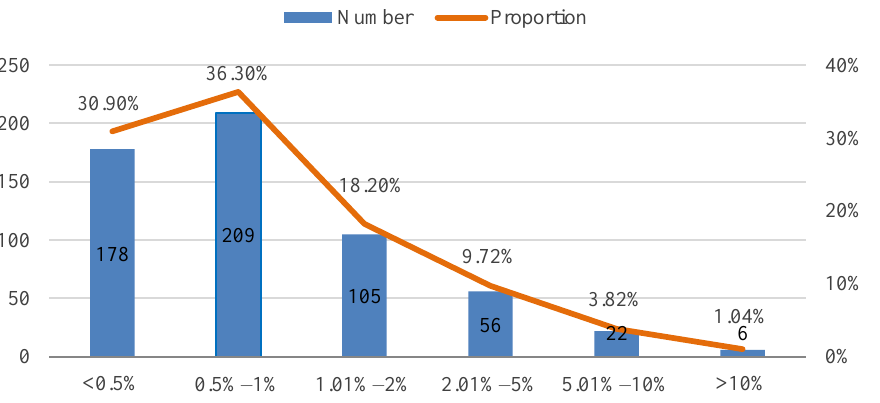
Figure 3. The premium range consumers are willing to pay for green express packaging.